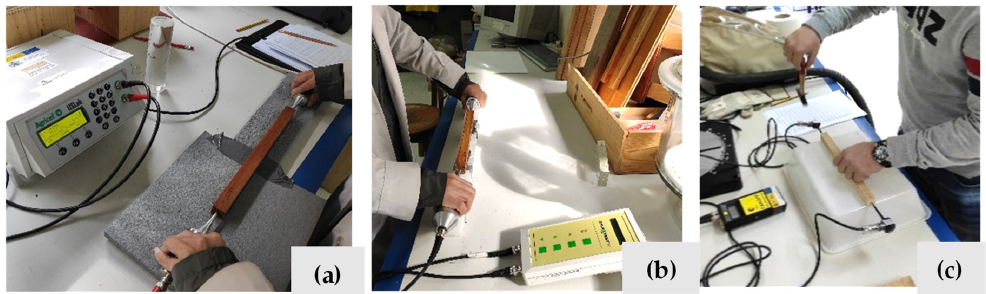
Figure 3. Nondestructive tests on specimens, direct measurements with USLab ( a ); Sylvatest Duo ( b ) and Microsecond Timer ( c ).